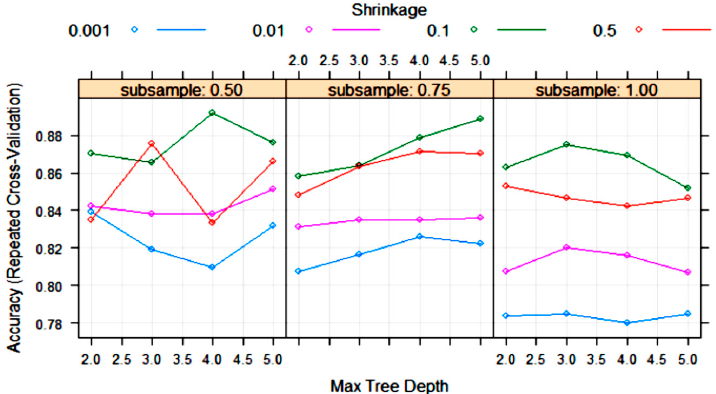
Figure 8. Change in the accuracy of XGBoost algorithm during training with 10-fold cross-validation with the parameters “max tree depth”, “shrinkage (eta)” and “subsample”. Tuning parameters